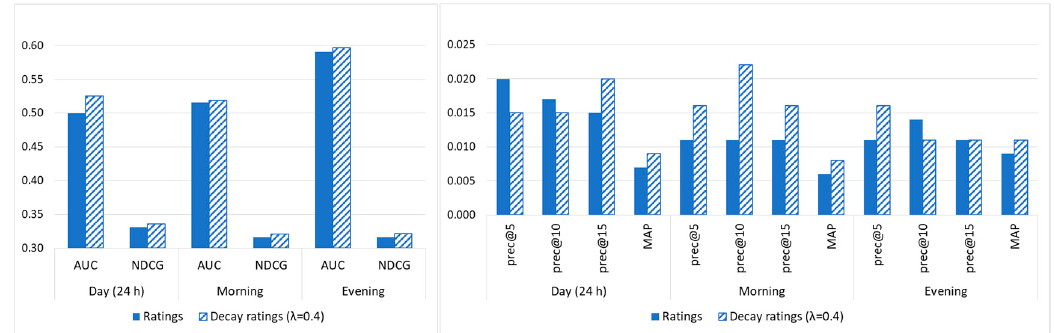
Figure 3. Values of the top-N metrics given by WRMF using the ratings and decay ratings for different day time periods.